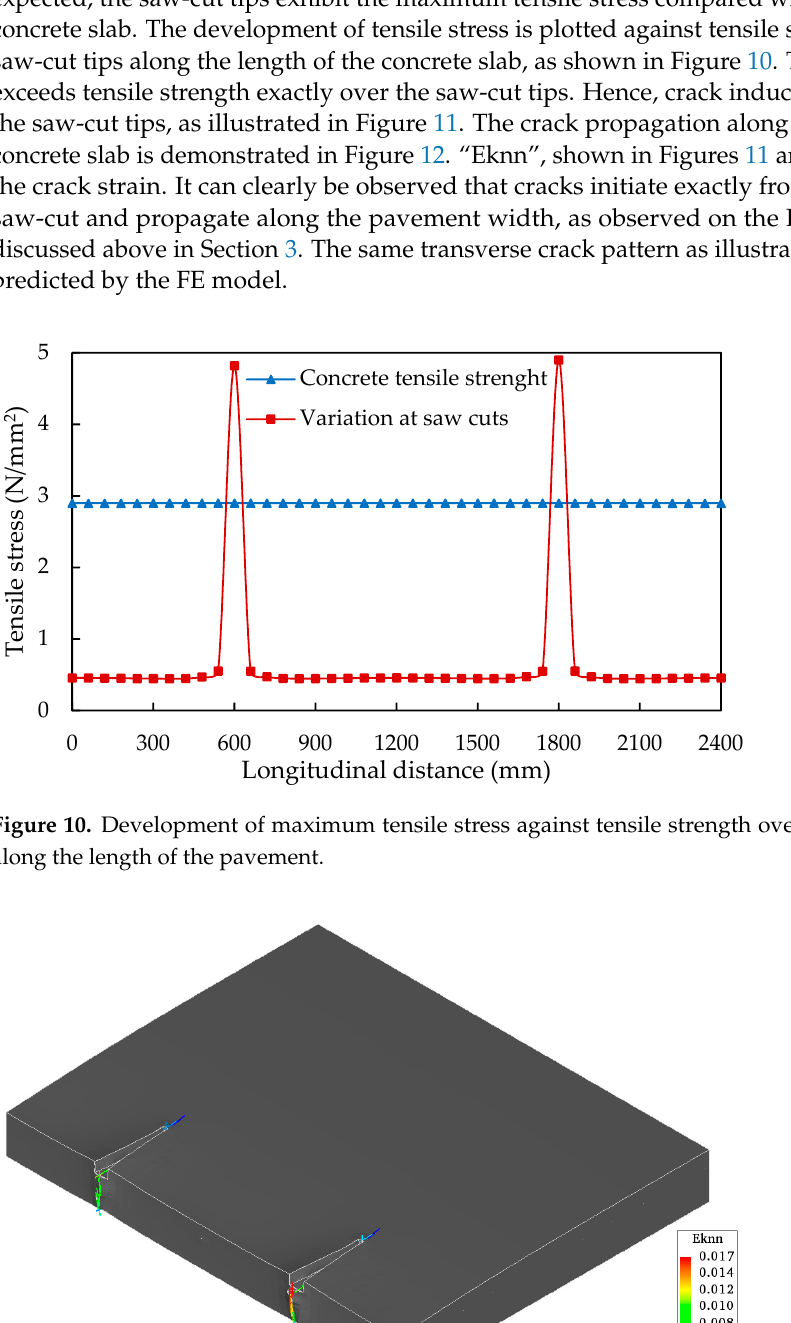
Figure 9. Boundary conditions of the FE model: ( a ) thermal boundary and ( b ) structural boundary.